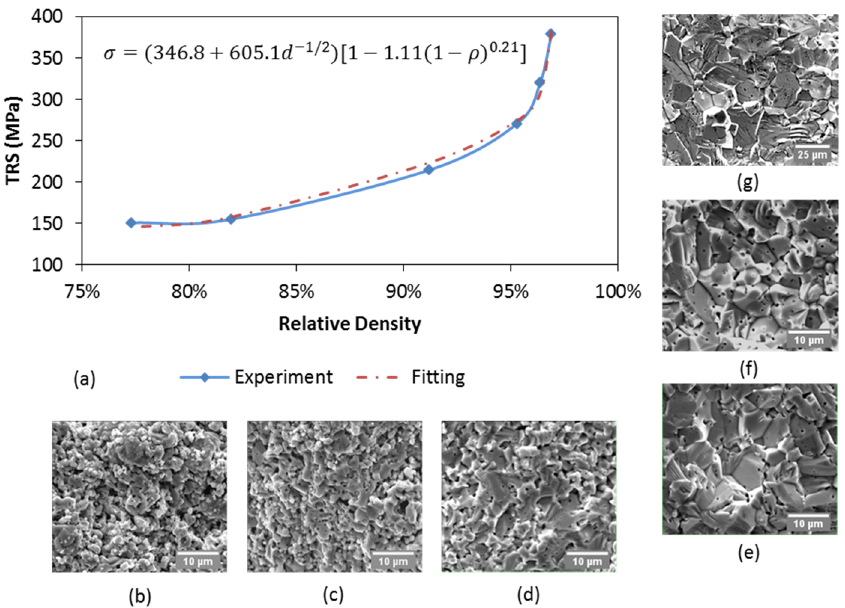
Figure 7. Transverse rupture test results and SEM images of fracture surfaces: ( a ) TRS